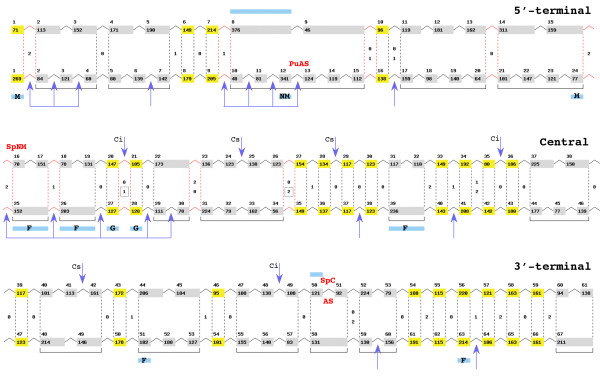
Comparison of huntingtin gene structure between Ciona intestinalis (upper line) and Homo sapiens (lower line). Only protein-coding regions are indicated. Exons are represented by boxes, with upper numbers indicating exon numbering and inner number indicating exon length (in bp). Box size is unrelated to exon length. Square bracket: exon-block (see text). Yellow box: equivalent exon (see text). Gray box: exon belonging to an exon-block (see text). Introns positionally conserved in the two species are represented by dashed lines, in black for identical intron position, in red for slipped position (changes ≤ 18 bp). Intron phase is reported between dashed lines as a single number if common to the two species. Boxed phase number indicates that intron phase is not conserved in one vertebrate species (see text). Blue boxes below or above the gene structure indicate exons with length differences > 12 bp in vertebrates (below) or in the Ciona genus (above). Letters inside blue boxes indicates the species where the size difference is observed: M, difference between mammals and other-vertebrates; NM, difference within non-mammalian vertebrates; F, difference between fishes and other-vertebrates; G, difference only in Gallus. Arrows indicate the 5% longest introns in at least one vertebrate species (below), and in the Ciona genus (above). AS: alternative splicing experimentally identified in C. intestinalis. PuAS: putative alternative splicing identified "in silico" in Gallus, Xenopus and pufferfishes. Sp: presence of lineage-specific sequences only in non-mammalian species (SpNM) or only in Ciona (SpC).